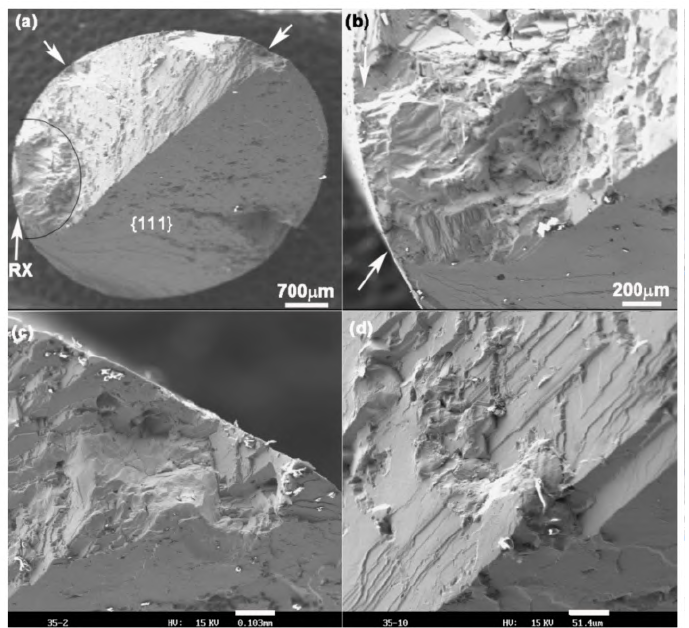
Figure 6. Fracture surface of SX alloy with local recrystallization at 550 ◦ C ( ε n = 0.7%, N f = 988 cycles); ( a ) fracture surface; ( b ) crack initiation site; ( c ) secondary fatigue crack initiation site; ( d ) slip deformation and river patters on {111} slip planes.